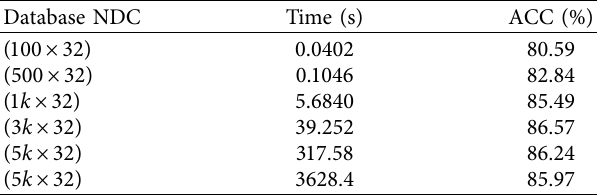
Table 4: Computational results of